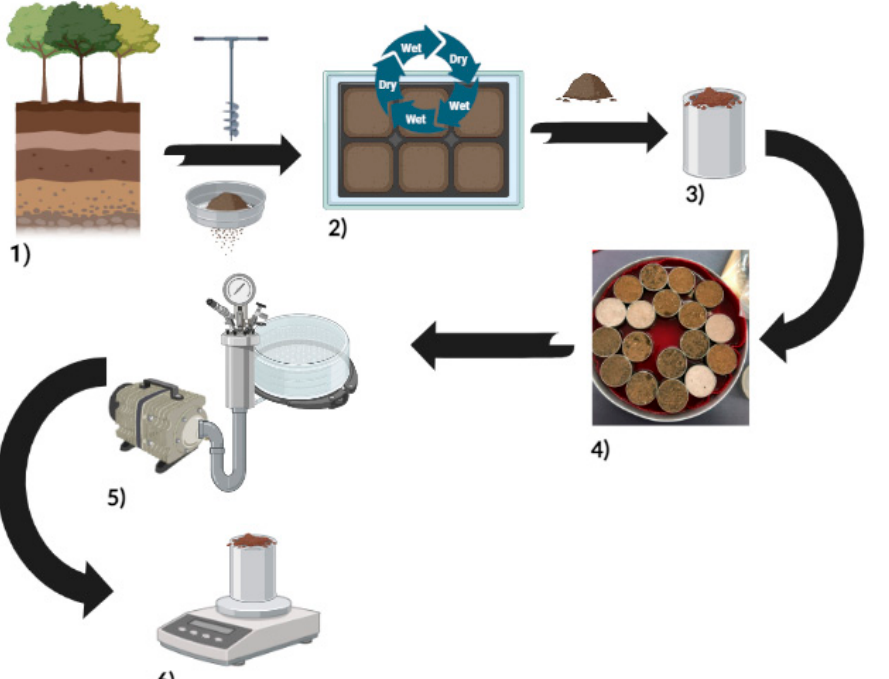
Figure 1. Experimental setup. ( 1 ) Soils were collected from three farmlands; ( 2 ) soil and improver were mixed in pots, buried in a field, left undisturbed for 6 months, and subjected to natural wet–dry cycles; ( 3 ) cylinder soil cores were collected from the pots; ( 4 ) cylinder soil cores were saturated; ( 5 ) cylinder soil cores were charged in the pressure-plate apparatus; ( 6 ) cylinder soil cores where weighed after each pressure level was applied.